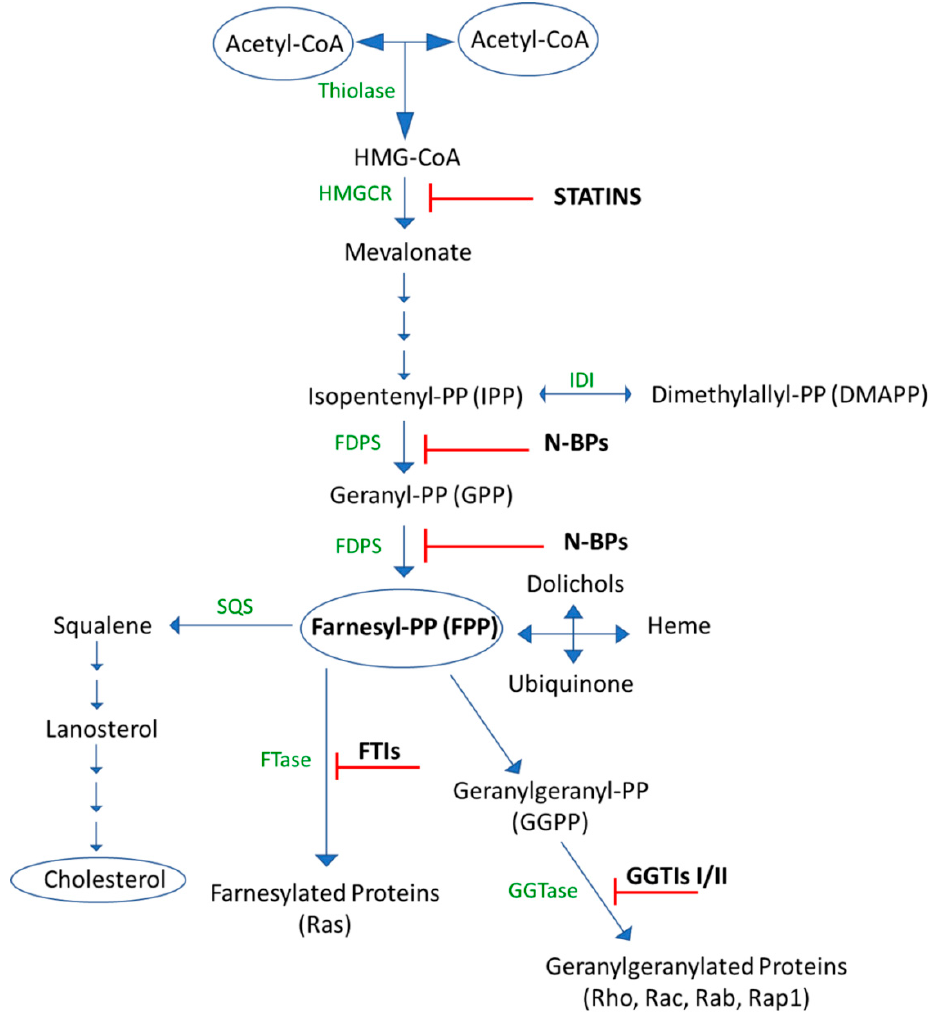
Figure 2. Schematic overview of the mevalonate pathway, isoprenoid/sterol biosynthesis and prenylation of proteins. Statins block HMGCR activity. Nitrogen-containing bisphosphonates (N-BPs) inhibit FDPS activity. Farnesyl transferase inhibitors (FTIs) and geranylgeranyl transferase inhibitors I/II (GGTIs I/II) inhibit protein farnesylation and geranylgeranylation, respectively. Farnesyl pyrophosphate synthase (FPPS, also known as Farnesyl diphosphate synthase FDPS), a key branchpoint of the mevalonate pathway, catalyzes two sequential